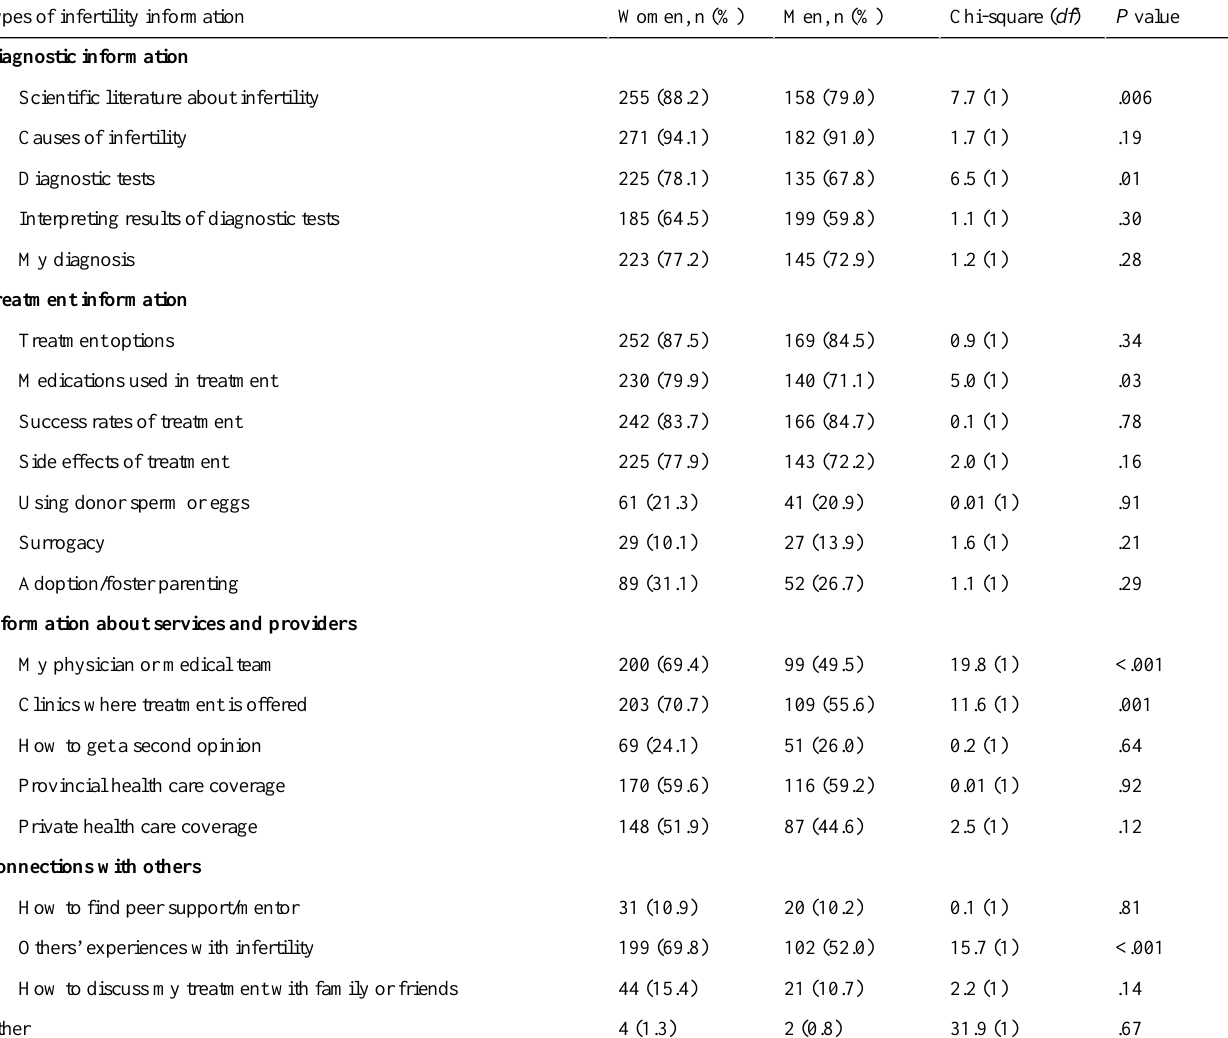
Table 2. Comparison of topics searched by men (n=200) and women (n=290) who reported using the internet to access infertility-related information and support